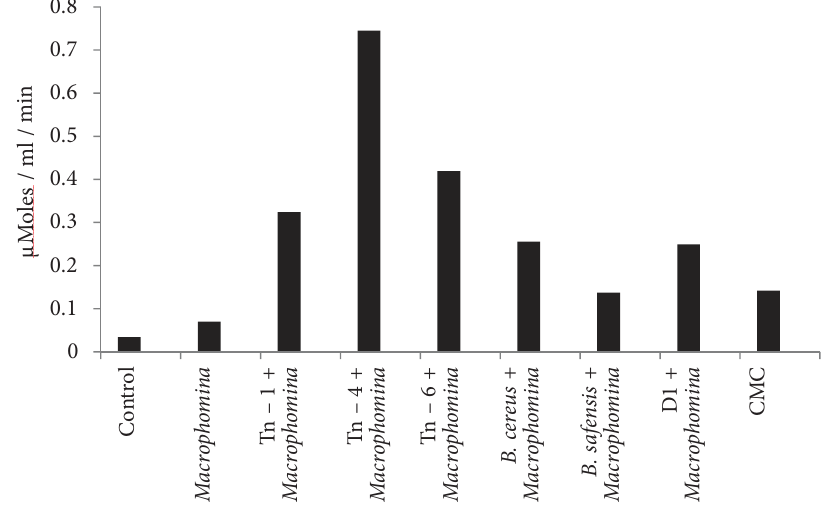
Figure 9. Graphical representation of chitinase activity in rhizobacteria treated plant